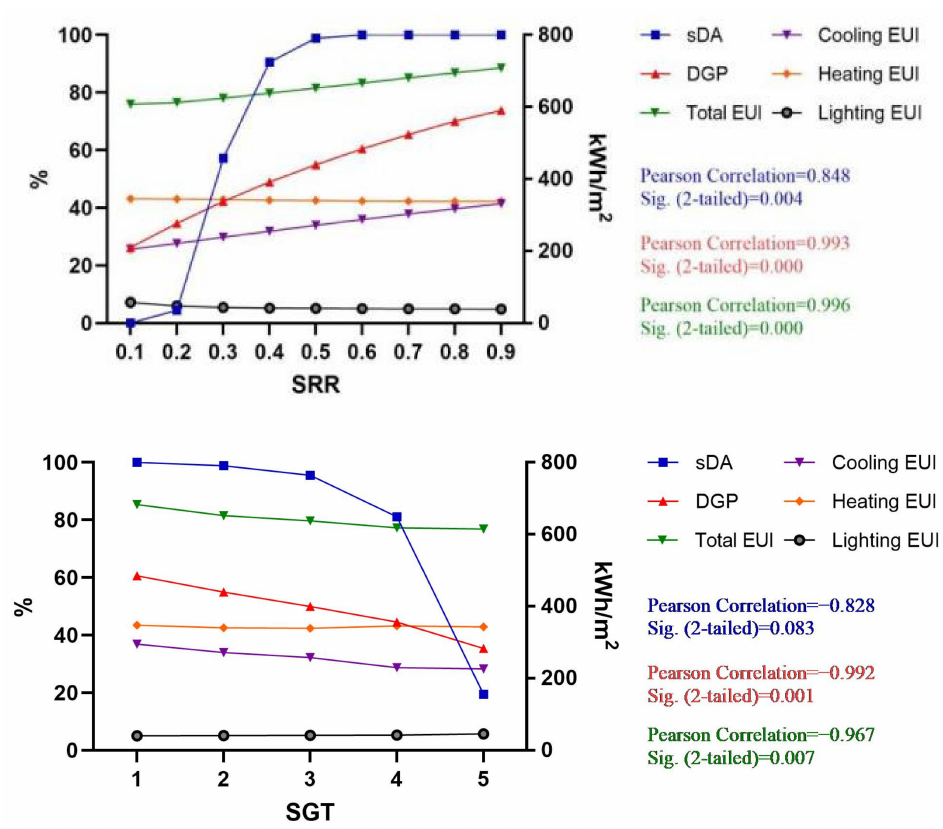
Figure 12. Simulation results of no